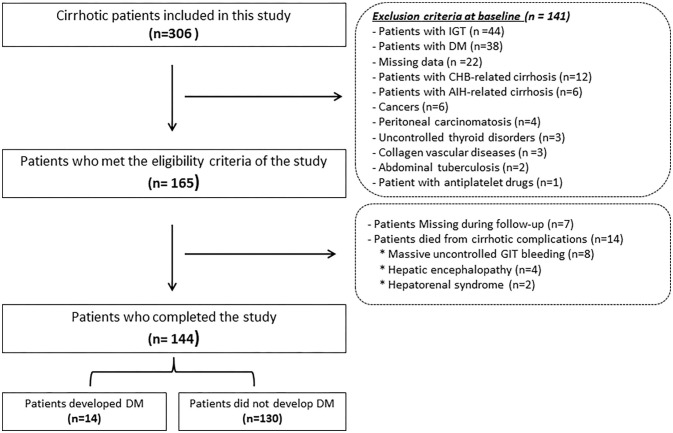
Flowchart of the patients included in this study. IGT, Impaired glucose tolerance; DM, diabetes mellitus; CHB, chronic hepatitis B; AIH, autoimmune hepatitis; GIT, Gastrointestinal tract.